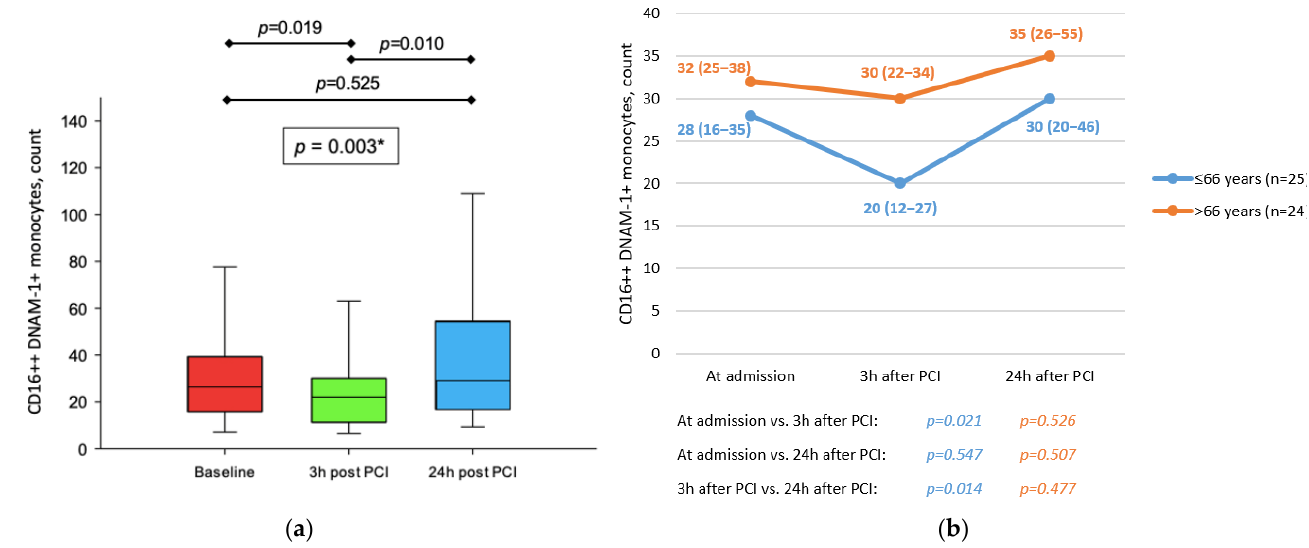
Figure 3. ( a ) Dynamic of CD16++DNAM-1+ monocytes in peripheral blood in patients with STEMI treated with primary PCI. * Friedman test with post hoc Conover test. ( b ) Comparison between dynamic of CD16++CD226+ monocytes in peripheral blood in patients with STEMI treated with primary PCI with respect to age. All data are presented as median (interquartile range).